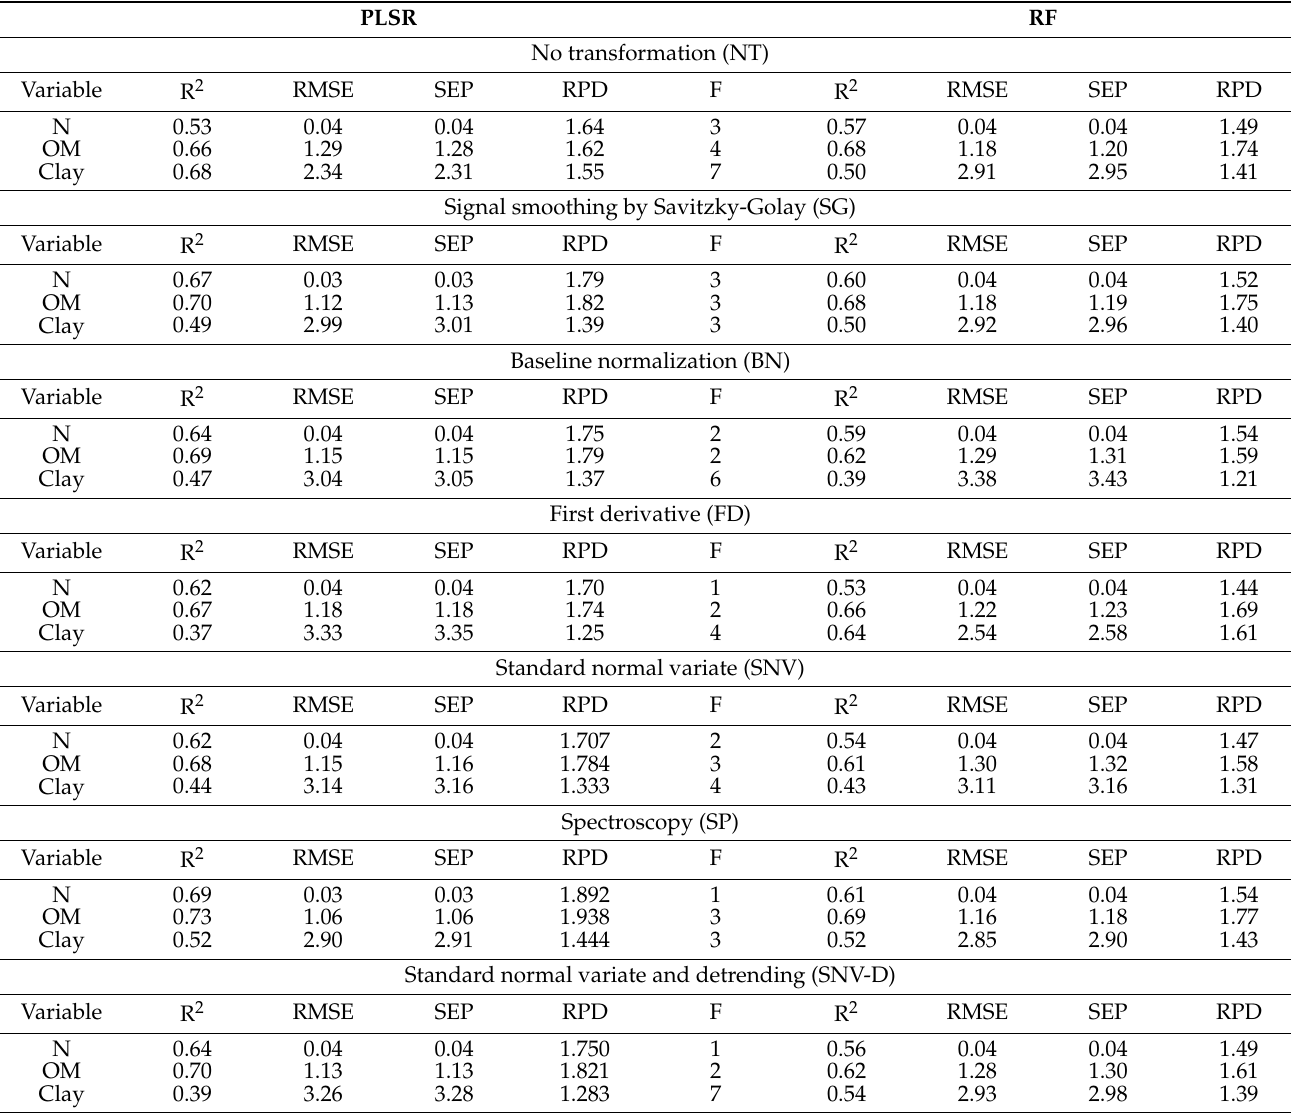
Table 4. Statistics of PLSR and RF regression models using the different transformations of spectral data as prediction variables. Transformations were applied to full spectral range (350–2500 nm). PLSR RF No transformation (NT)